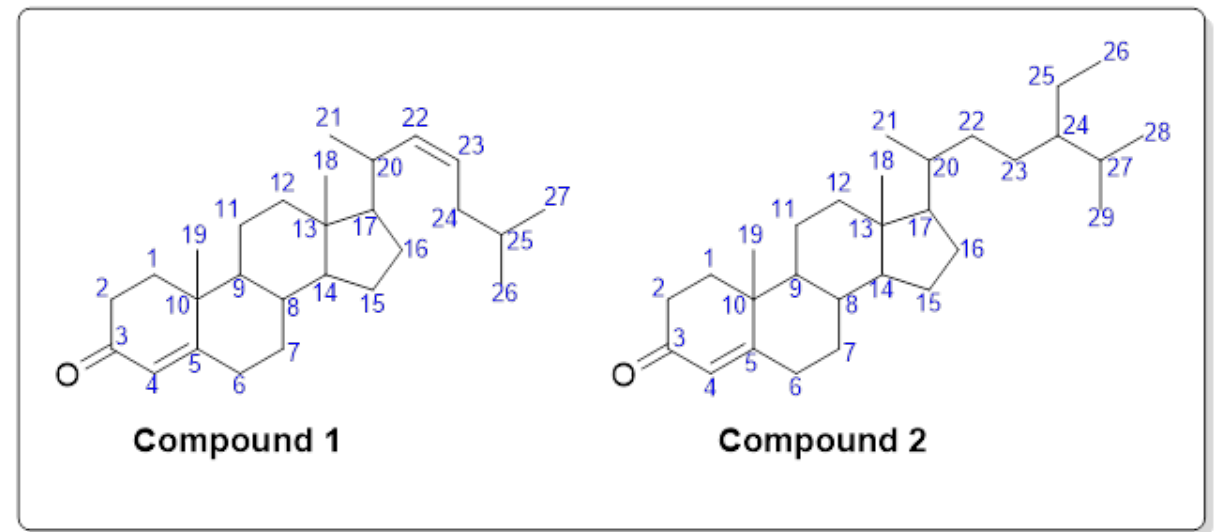
Figure 1. Structure of isolated compounds from Fragaria × ananassa .